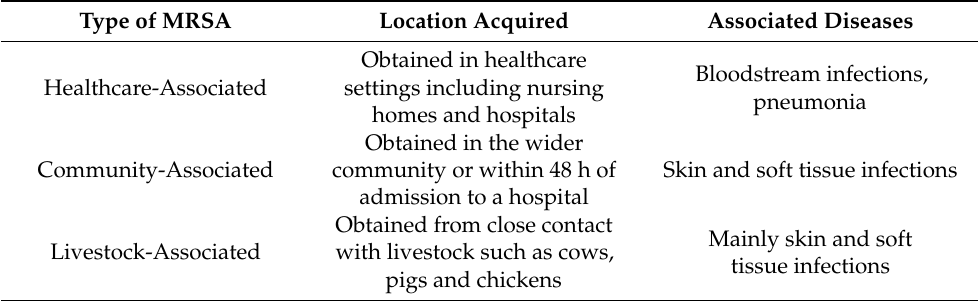
Table 1. Characteristics of healthcare-associated, community-associated and livestock-associated methicillin resistant S. aureus . Type of MRSA Location Acquired Associated Diseases Obtained in healthcare Bloodstream infections, Healthcare-Associated settings including nursing pneumonia homes and hospitals Obtained in the wider Community-Associated community or within 48 h of Skin and soft tissue infections admission to a hospital Obtained from close contact Mainly skin and soft Livestock-Associated with livestock such as cows, tissue pigs and chickens